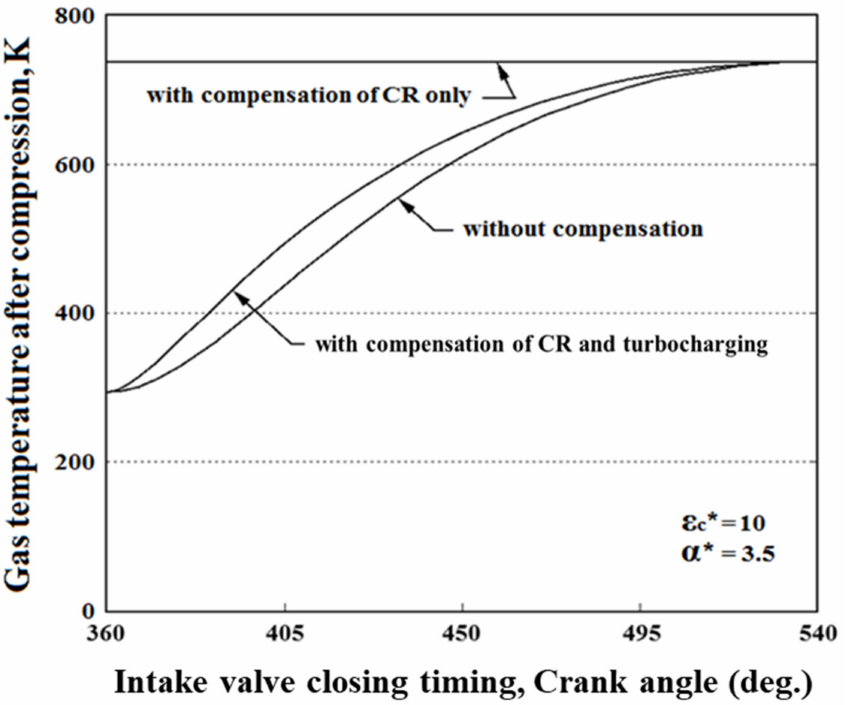
Figure 8. Gas temperature after compression according to change intake valve closing